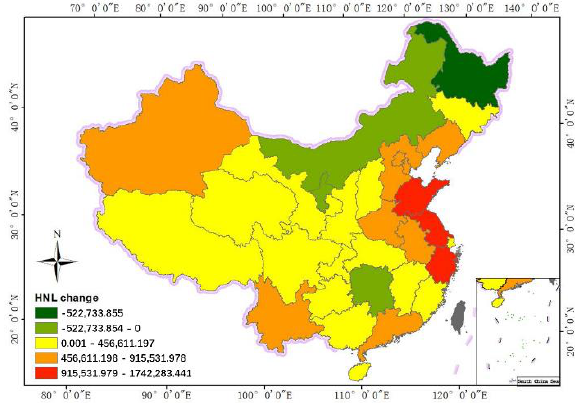
Figure 16. Changes in the highway nighttime light.